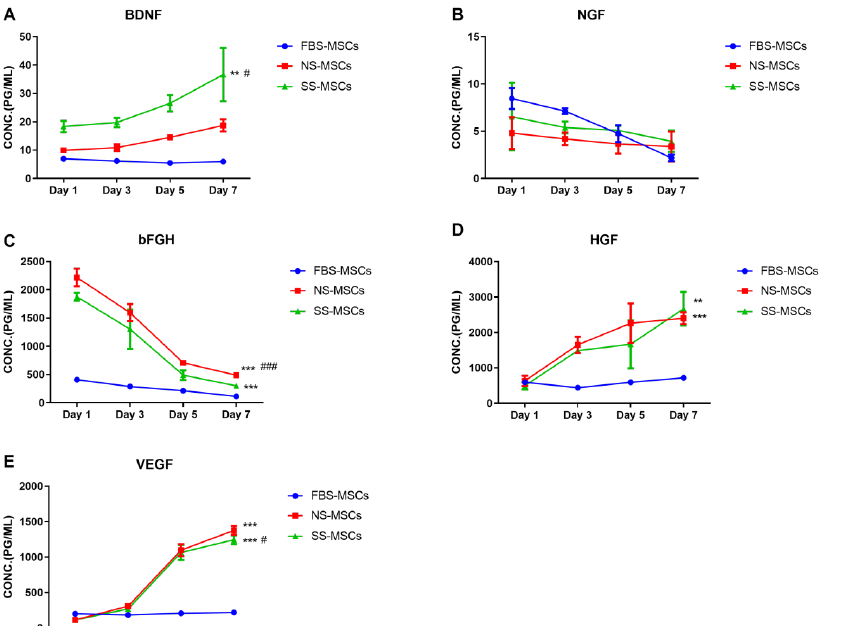
Figure 2. Comparative analysis of paracrine factors secreted by MSCs after pretreatment of rat cerebral infarction tissue ( x ± s , n = 3): ( A ) brain-derived neurotrophic factor (BDNF), ( B ) nerve growth factor (NGF), ( C ) basic fibroblast growth factor (bFGF), ( D ) hepatocyte growth factor (HGF), ( E ) vascular endothelial growth factor (VEGF). ** p < 0.01, N-MSCs treated group versus FBS-MSCs group. *** p < 0.001, S-MSC group versus FBS-MSCs group. # p < 0.05, ### p < 0.001, S-MSC-treated group versus N-MSCs group.